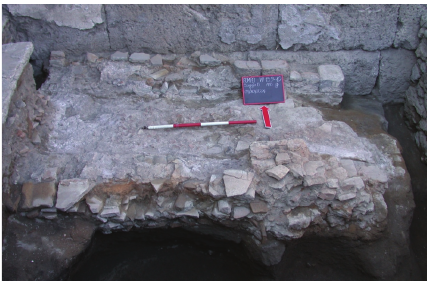
Figure 2: Furnace situated below the triclinium of domus VII, 15,